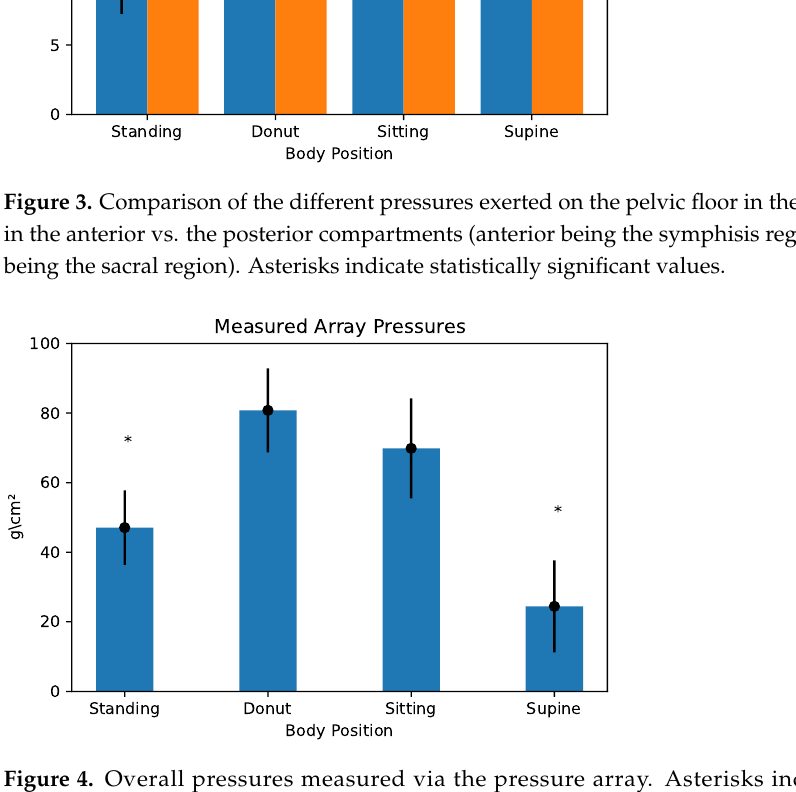
Figure 4. Overall pressures measured via the pressure array. Asterisks indicate statistically significant